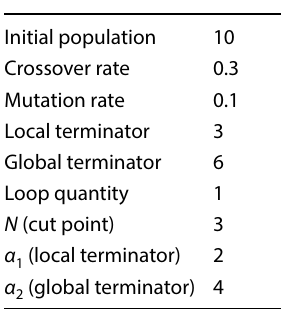
Table 2 Parameters of